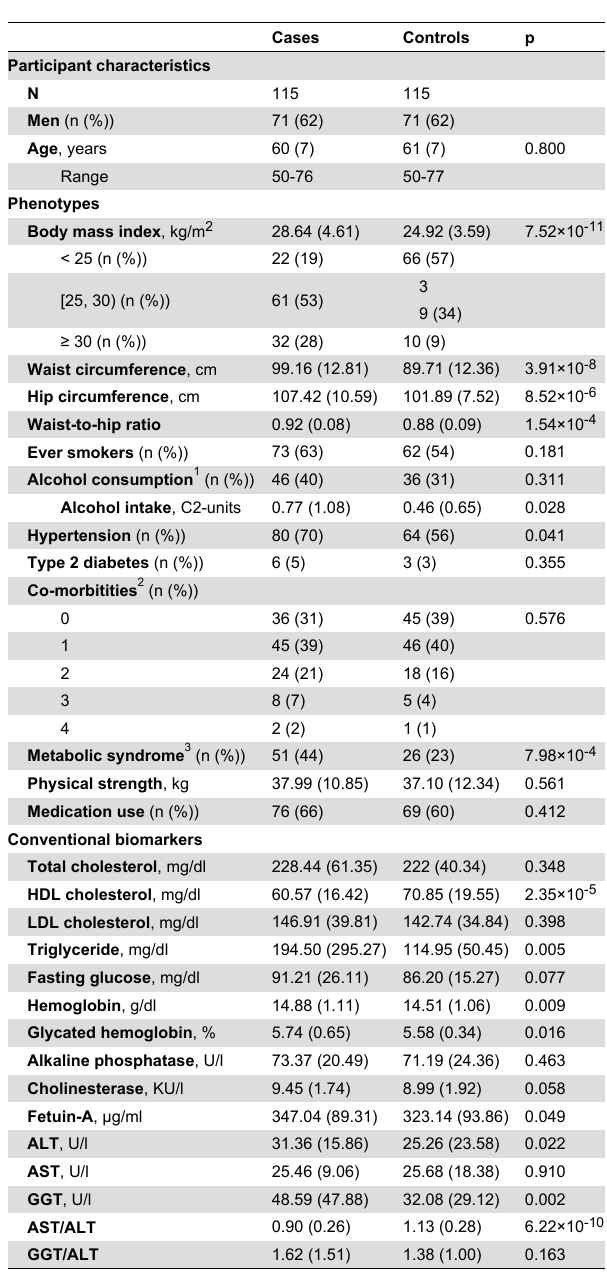
Table 1. Study population